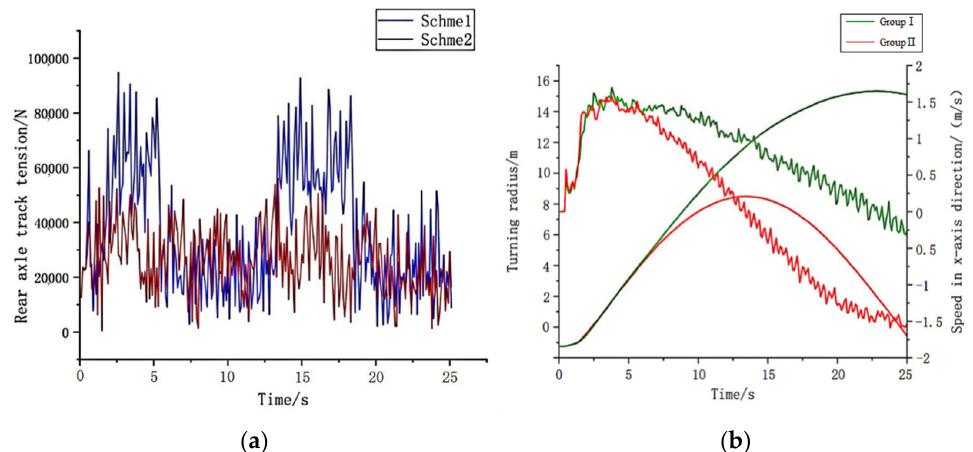
Figure 11. Track tension:( a ) rear axle track tension and ( b ) turning radius and speed in x -axis direc- tion.